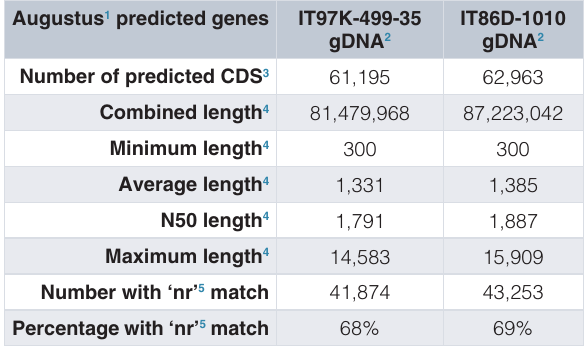
Table 4. Details of predicted coding gene sequences with 300bp minimum length predicted by Augustus within the assembled genomic DNA contig sets from IT97K-499-35 and IT86D-1010. Matches to NCBI’s ‘nr’ protein sequence database found through ‘blastp’ of translated predicted genes, with an e-value threshold of 1e-50.